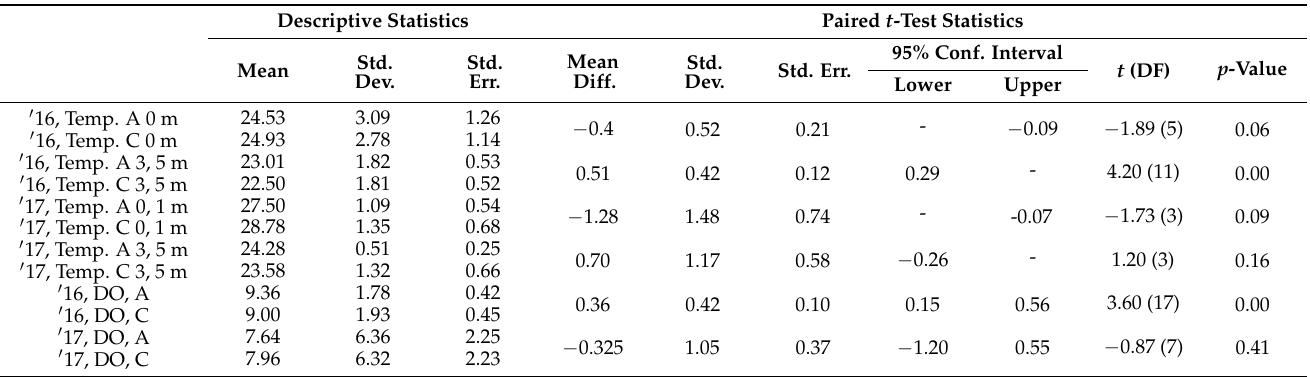
Table 2. Paired t -test results for water temperature and dissolved oxygen (DO) at each location and water depth in 2016 and 2017 seasons.